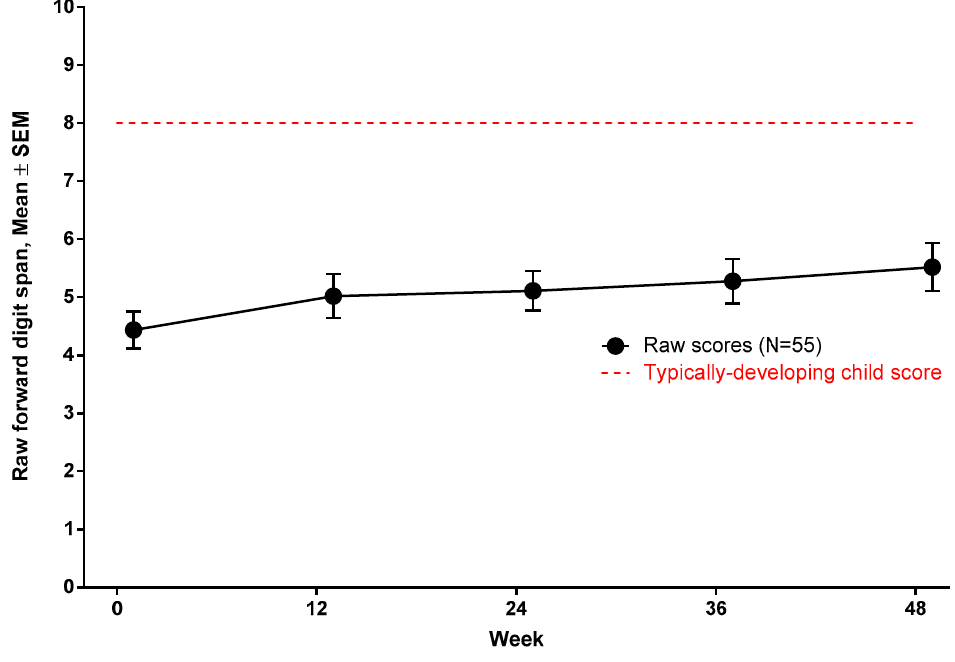
Figure 4. Developmental maturation of working memory in nmDMD.